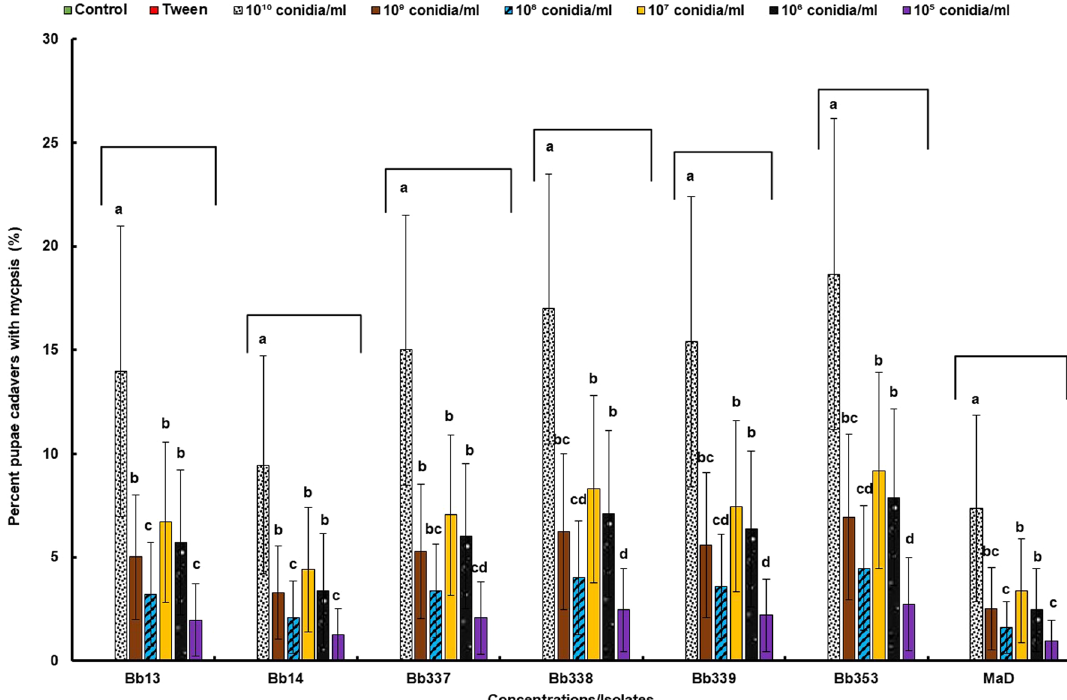
Fig. 5 Cadavers of Zeugodacus cucurbitae pupae with fungal growth after treatment different concentrations of isolates of Beauveria bassiana and Metarhizium anisopliae in larval inoculation method